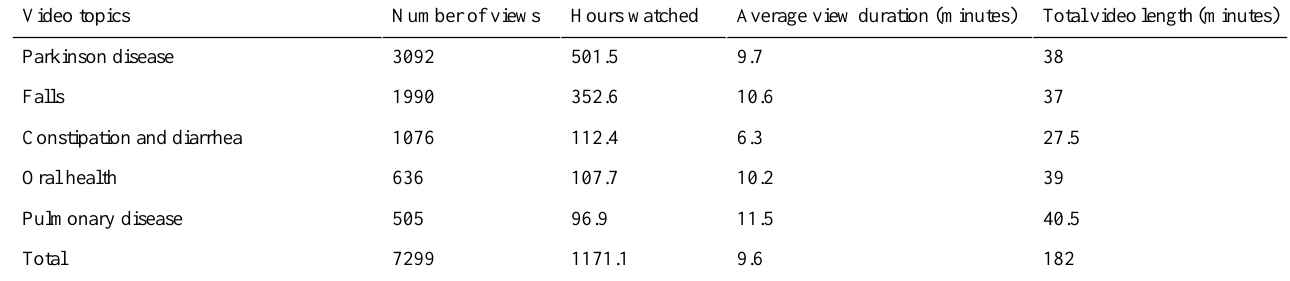
Table 1. Statistics of 5 videos over 40